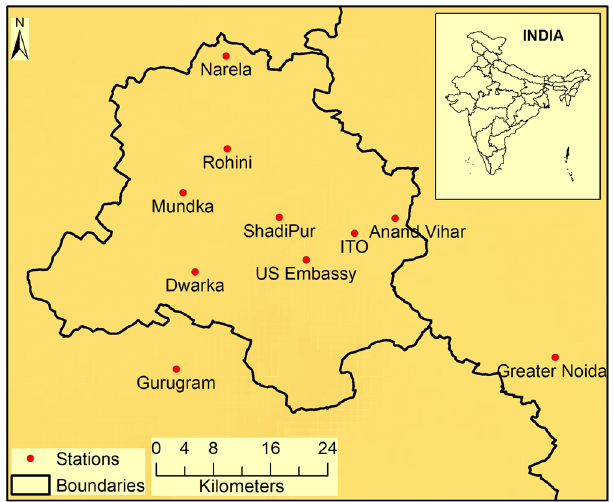
Figure 1. Locations of the stations are shown on the Map of Delhi, Two stations [Gurugram and Greater Noida represent part of National Capital Region (NCR)]. Stations represent both outskirt and center of the city. Map is generated using software ArcGIS